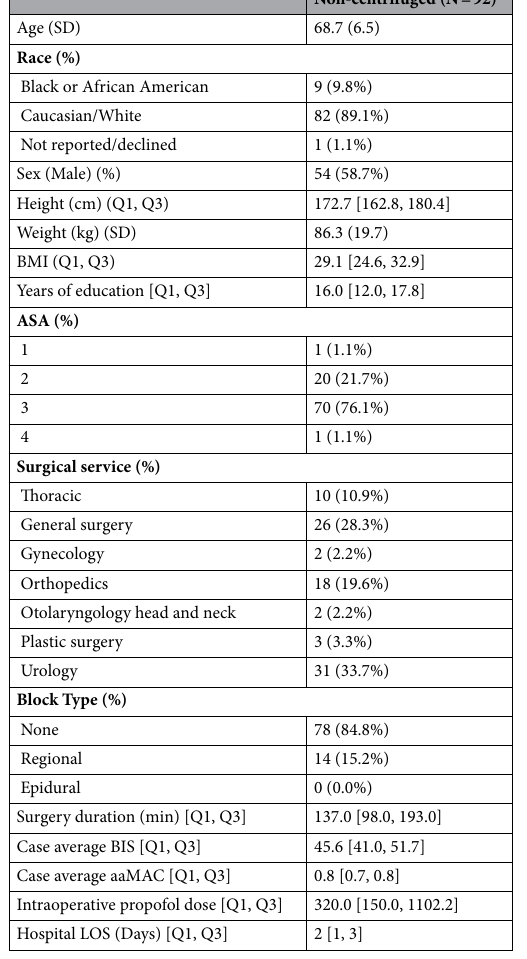
Table 1. Patient characteristics for non-centrifuged samples. Average bispectral index (BIS) values were calculated from 66 patients in the non-centrifuged group. Case average age-adjusted minimum alveolar concentration (aaMAC) was calculated for those patients who received an inhaled anesthetic for more than half of the case; N = 49 in the non-centrifuged sample group. American Society of Anaesthesiologists scores (ASA) are presented as percentages of non-centrifuged patient samples and centrifuged patient samples. Hospital length of stay (LOS) values are listed in